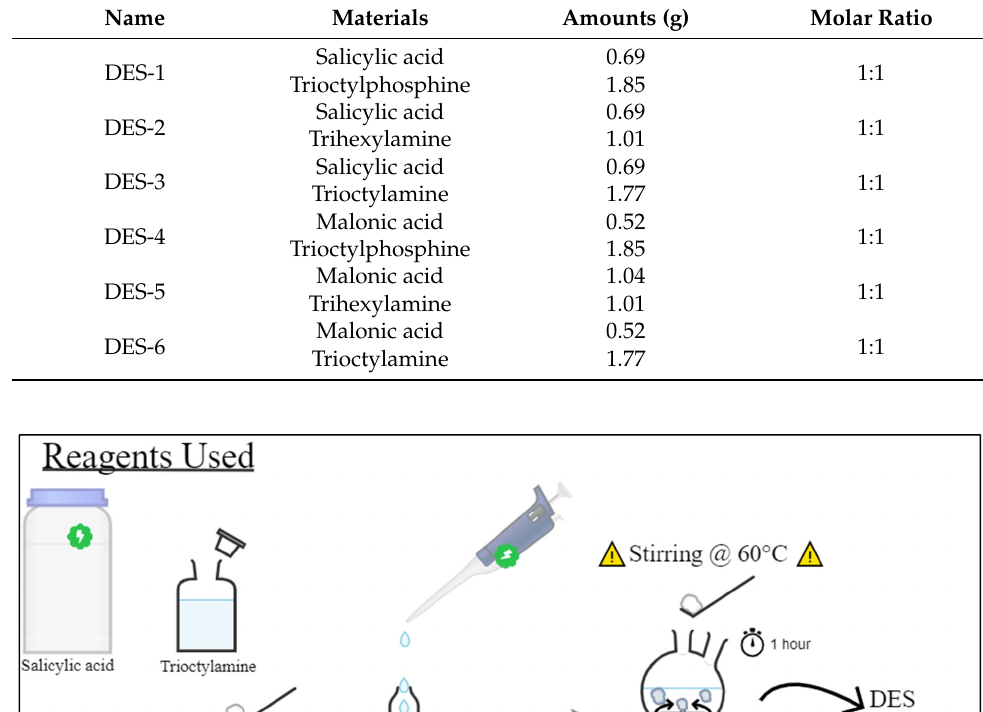
Table 1. HBDs and HBAs and their proportion used for the preparation of DESs.